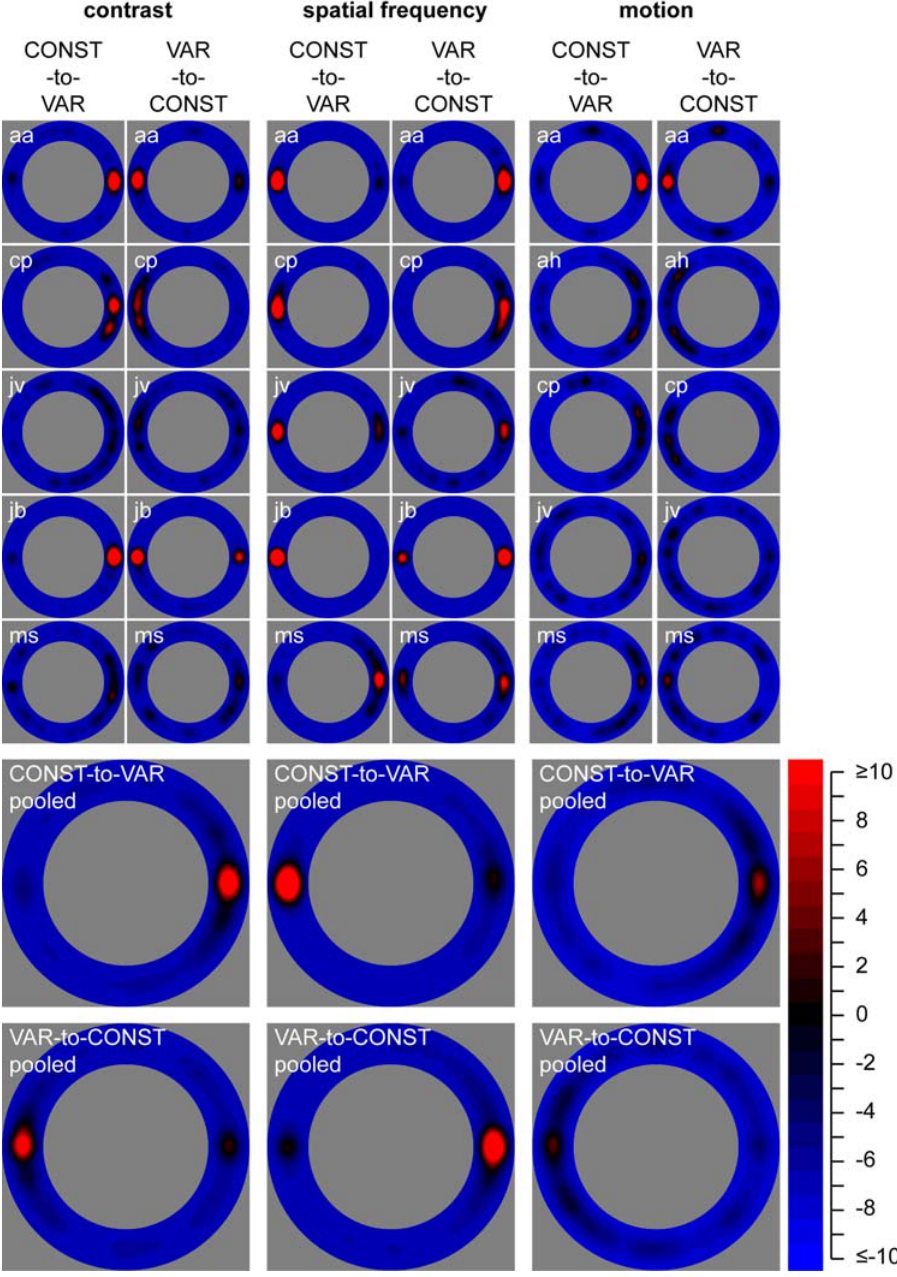
Figure 4. Results. The first five rows show results of individual observers for each of the experiments. For each experiment, the left column represents z-scores for the CONST-to-VAR conditions, and the right column represents z-scores for the VAR-to-CONST conditions. The bottom two rows show pooled results for each of the experiments. Here, the first row of data represents z-scores for the CONST-to-VAR conditions for each of the experiments; the second row of data represents z-scores for the VAR-to-CONST conditions for each of the experiments. Importantly, the data represent most frequent mouse clicks for data rotated to the 0 deg position (as explained in the Results section). The colors in the graphs represent z- scores, where red indicates positive and blue negative z-scores.